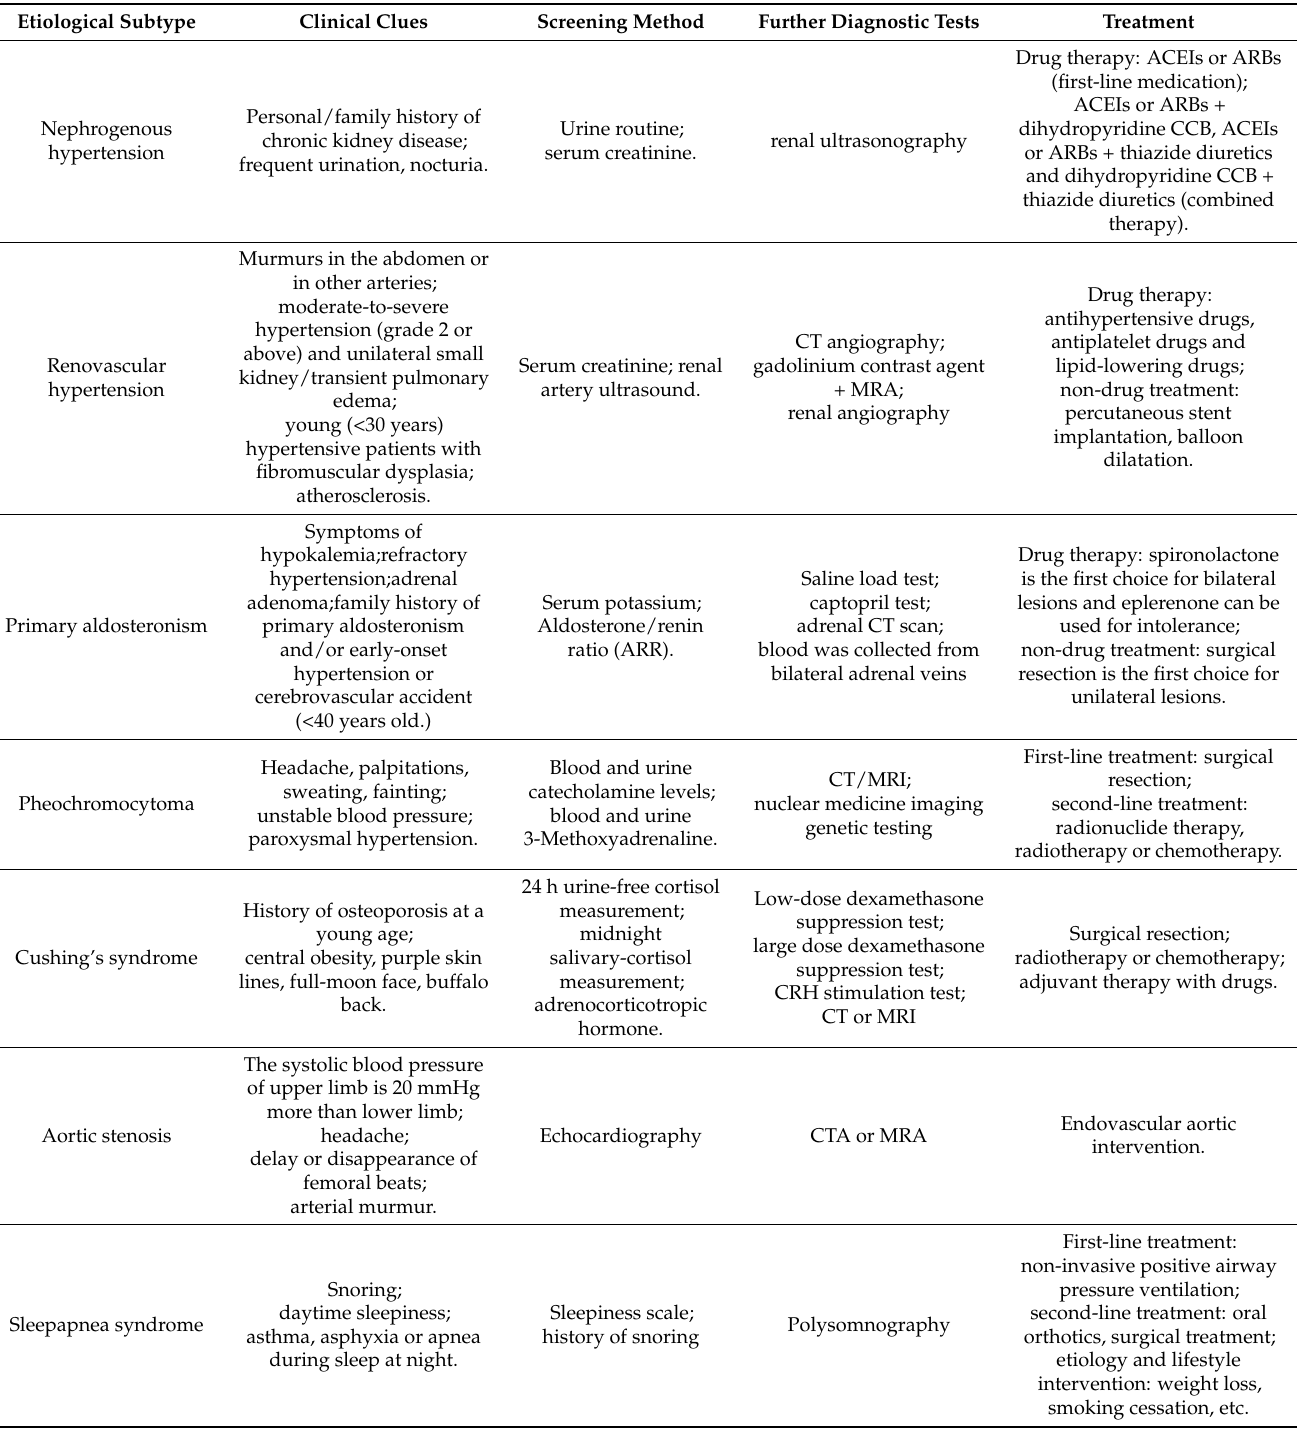
Table 1. Recommendations for the etiological typing of secondary hypertension and its examination and